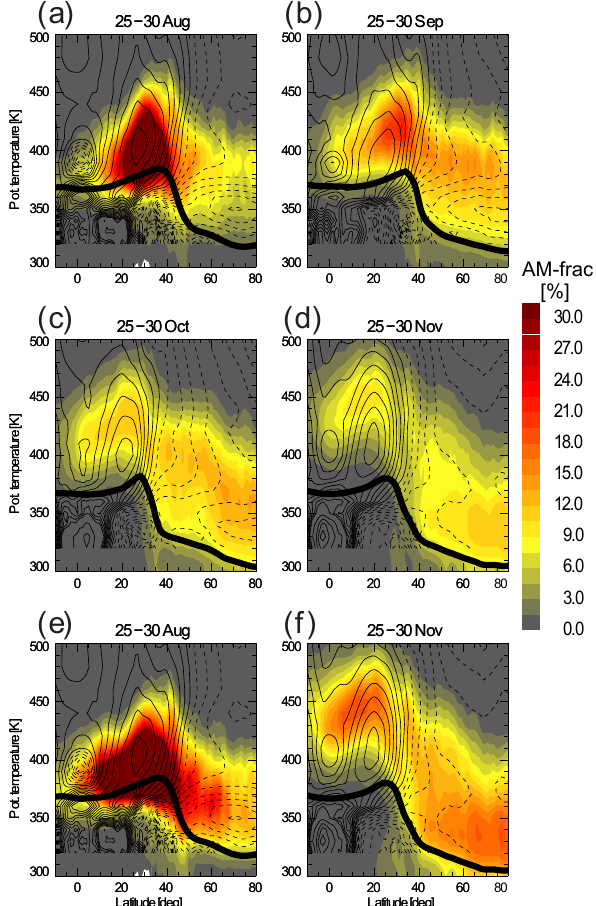
Figure 4. Latitude section of monsoon air mass fraction aver- aged over longitudes between 40 and 100 ◦ E for the (climatolog- ical 2010–2013) periods 25–30 August (a) , September (b) , Octo- ber (c) , and November (d) . The averaging has been carried out in tropopause-based vertical coordinates, and the data have afterwards been adjusted vertically for plotting by adding the mean tropopause potential temperature (grey line). (e, f) Same as (a, d) but for the monsoon edge fraction, calculated from the monsoon edge tracer (see text). Thin black contours show total diabatic vertical velocity d θ/ d t (positive values solid, negative values dashed, contour spac- ing 0 . 2Kday − 1 ), the thick black line shows the mean tropopause. All quantities are averaged between 40 and 100 ◦ E.